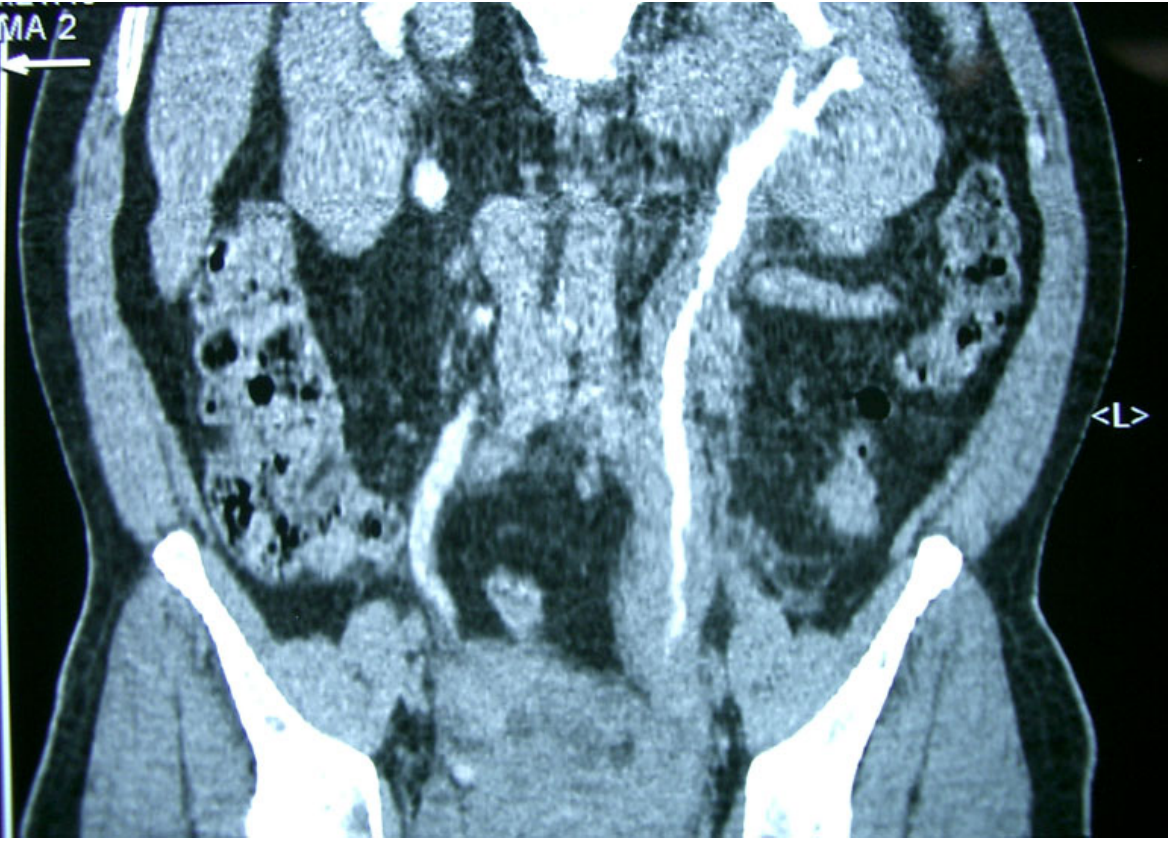
FIGURE 2. Coronal reformatting of the computed tomography images in Fig. 1 highlighting the extensive involvement of bladder and in particular the left ureter and